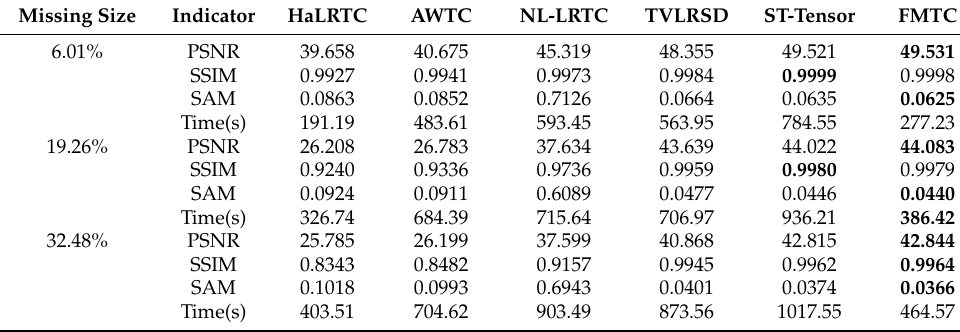
Table 4. Quantitative comparison of six algorithms with different missing sizes.